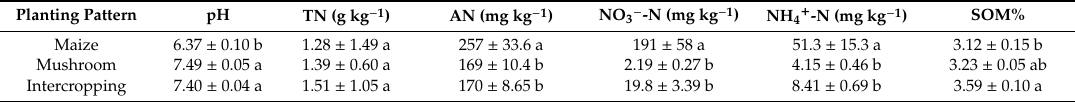
Soil chemical properties under maize monoculture, mushroom monoculture and maize–mushroom